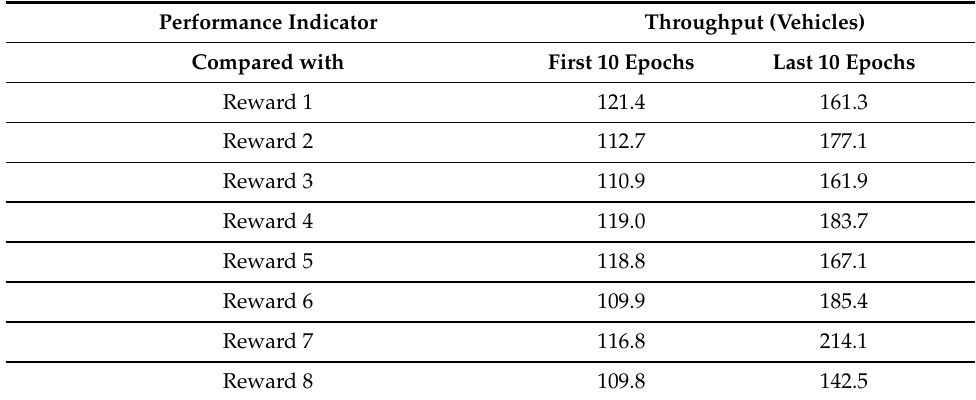
Table 5. Comparison of training results among 8 reward functions for throughput.